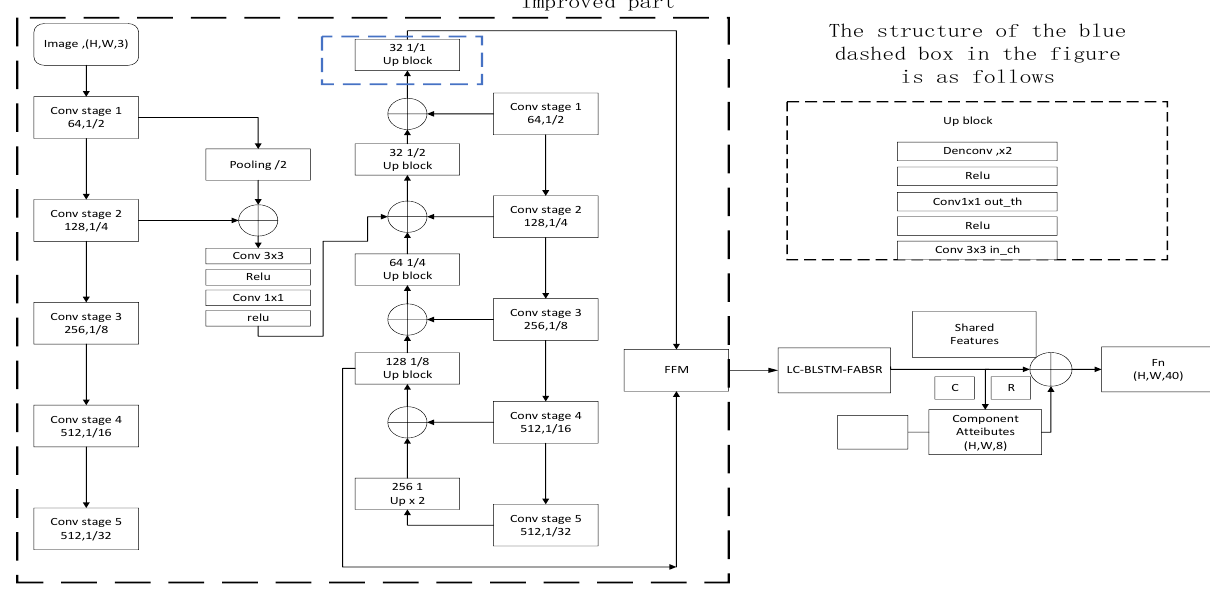
Figure 3. Construction block diagram of the improved algorithm.